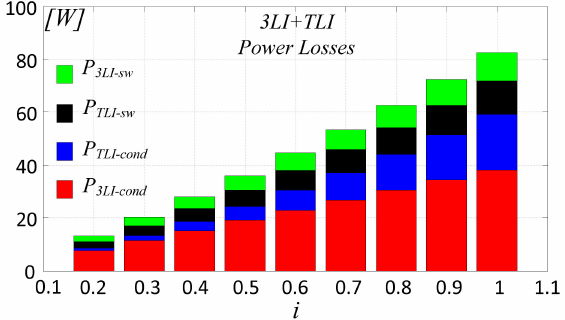
Figure 19. Power losses of 3LI + TLI vs. load current.